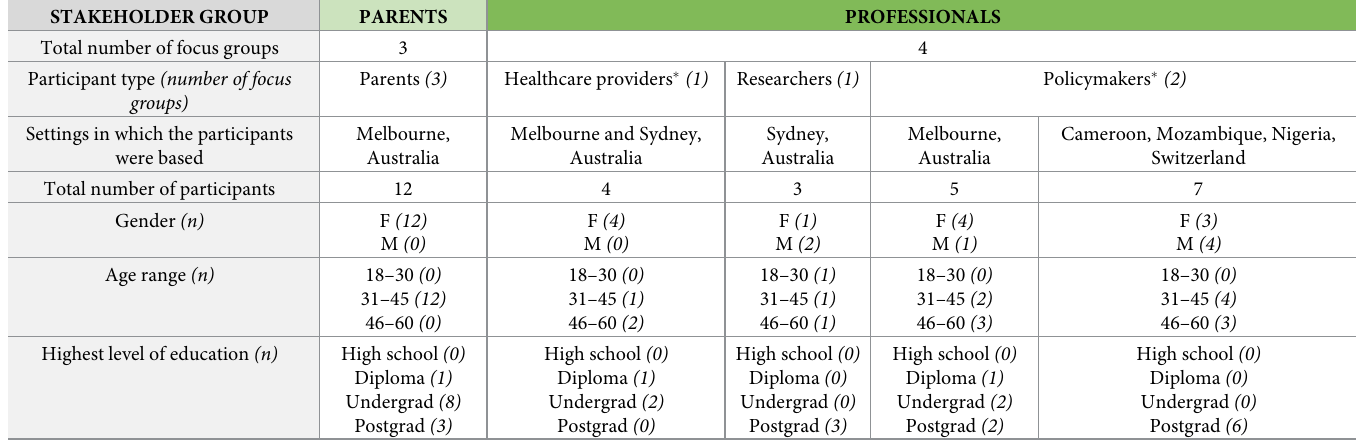
Table 1. Focus group participant